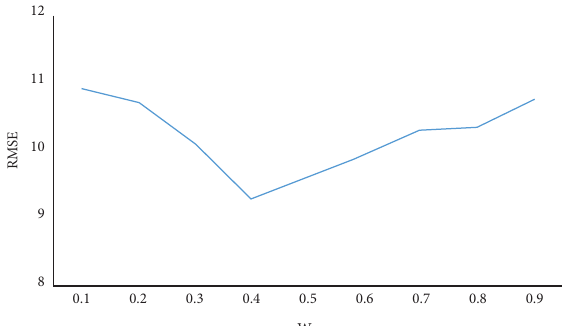
Figure 9: (a) Epoch. (b) Time step. (c) Batch